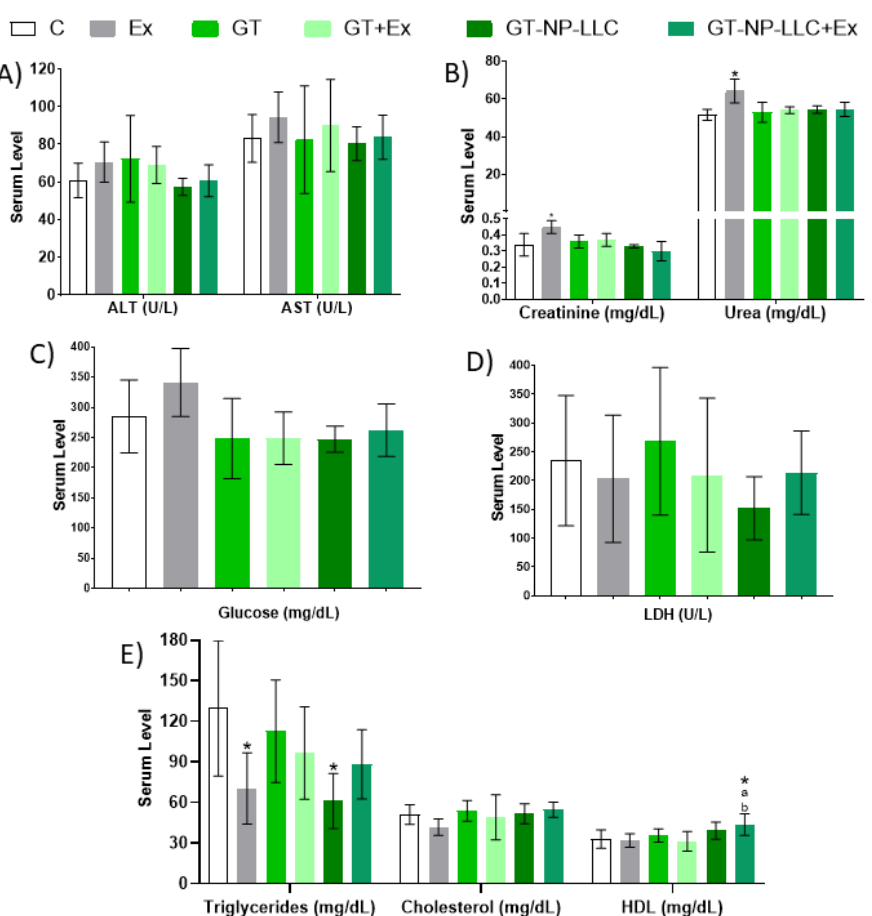
Figure 2. Biochemical evaluation. ( A ) Liver profile; ( B ) Renal profile; ( C ) Glucose concentration; ( D ) Lactate dehydrogenase (LDH) activity and in ( E ) Lipid profile. Note: Data reported by mean ± SD. Liver profile is represented by alanine aminotransferase (ALT) and aspartate aminotransferase (AST); Renal profile is represented by creatinine and urea; Lipid profile is reported by triglyceride, total cholesterol and high-density lipoprotein (HDL). * p < 0.05 compared to C, a p < 0.05 compared to Ex, b p < 0.05 compared to GT+Ex.